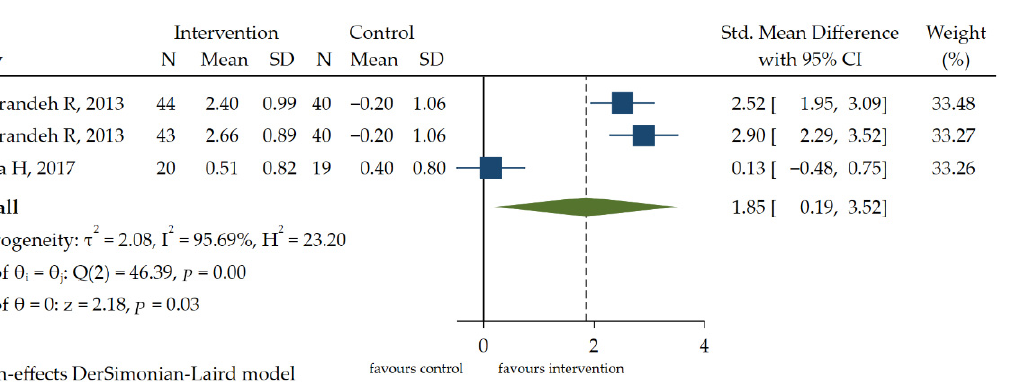
Figure 5. The forest plot of the effect of HL intervention on medication adherence.